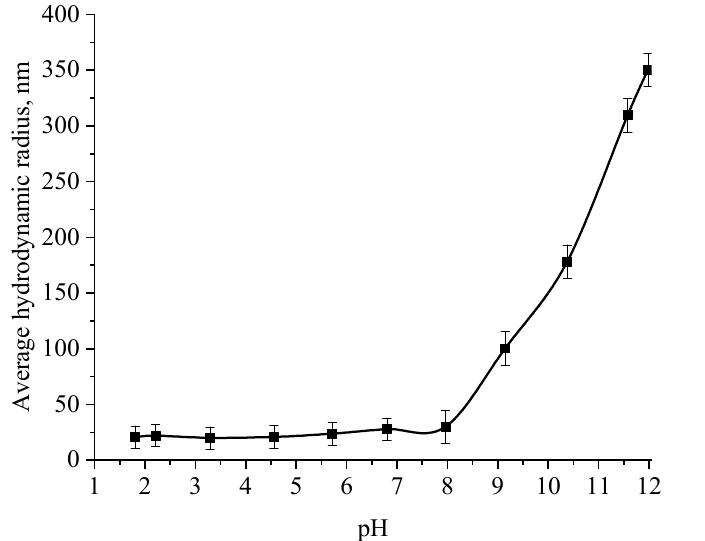
Figure 8. Graph of the dependence of the average hydrodynamic radius of the negative Se NPs sol on the active acidity pH.